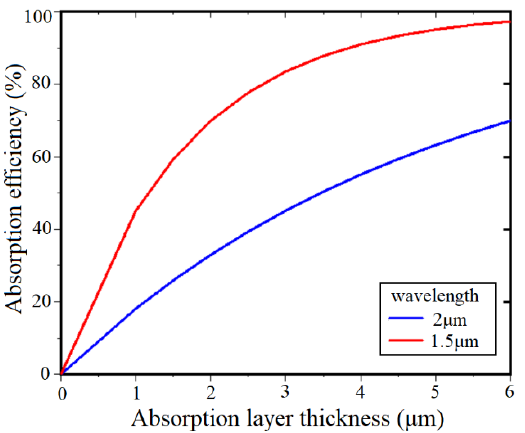
Figure 4. Diagram of absorption efficiency as a function of thickness.